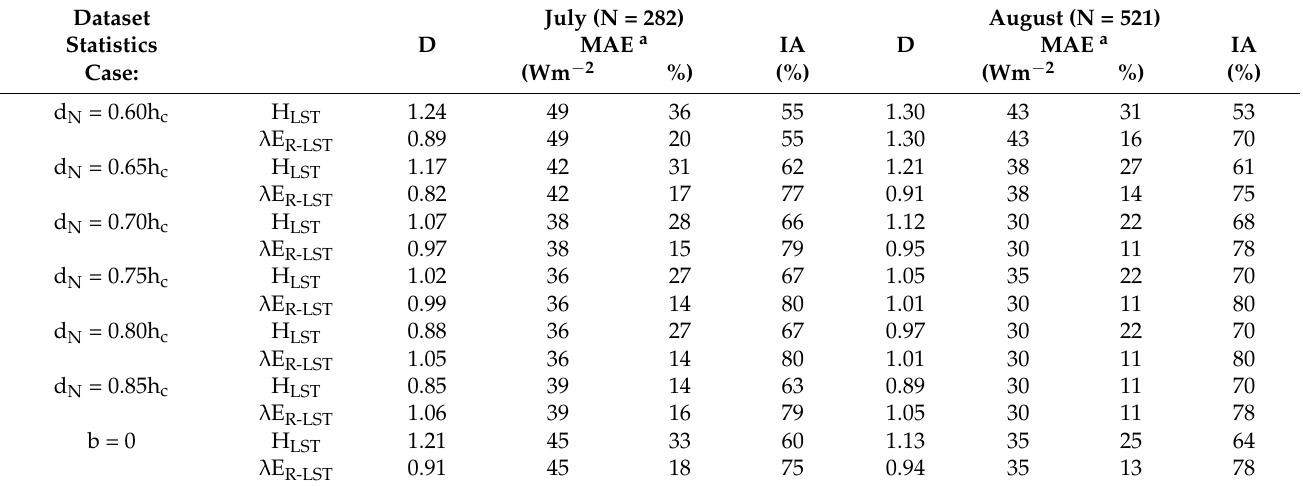
Table 2. LST sensible heat and latent heat flux estimates determined using different zero-plane displacements at neutral conditions and neglecting the offset.